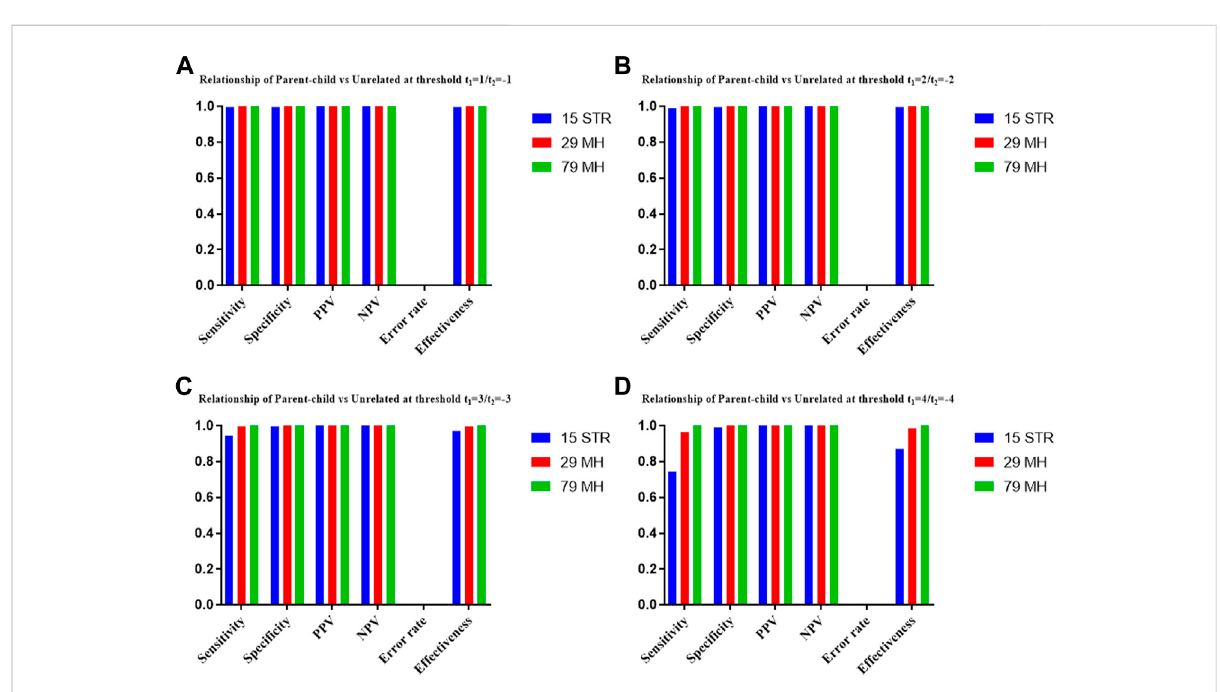
FIGURE 5 The system power based on the data of 15 STR loci, 29 microhaplotype loci and 79 microhaplotype loci for relationship parent-child vs. unrelated individualsat different threshold values. (A) Threshold t 1 =1/t 2 = − 1; (B) Threshold t 1 = 2/t 2 = − 2; (C) Threshold t 1 = 3/t 2 = − 3; (D) Threshold t 1 = 4/t 2 = −